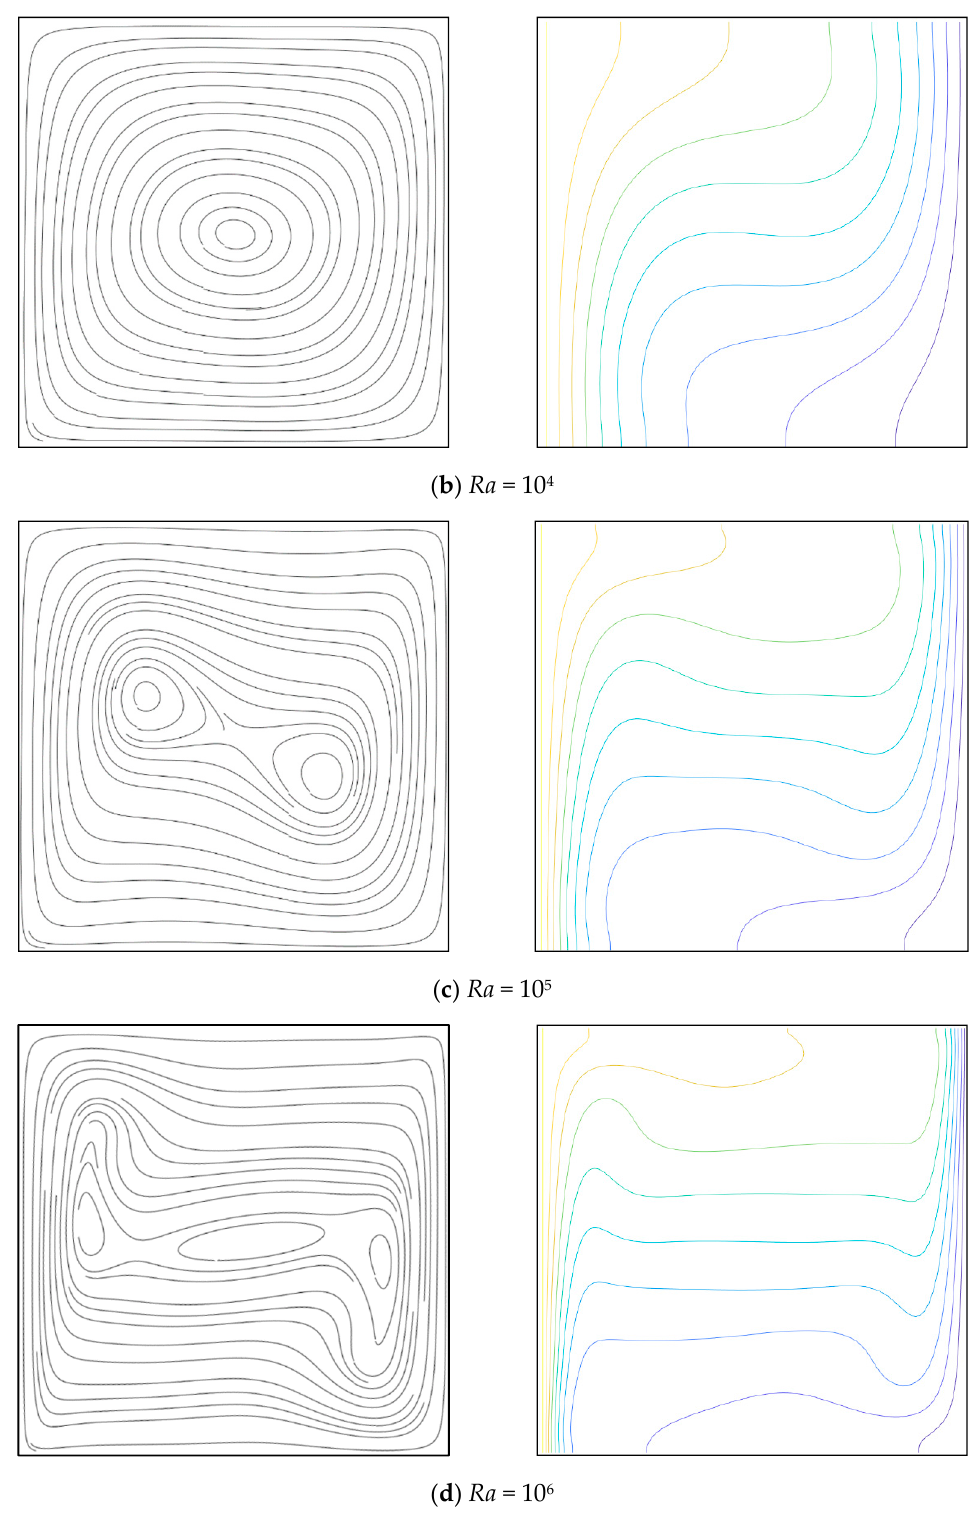
Figure 9. Streamlines and isothermal lines of natural convection for different Ra .